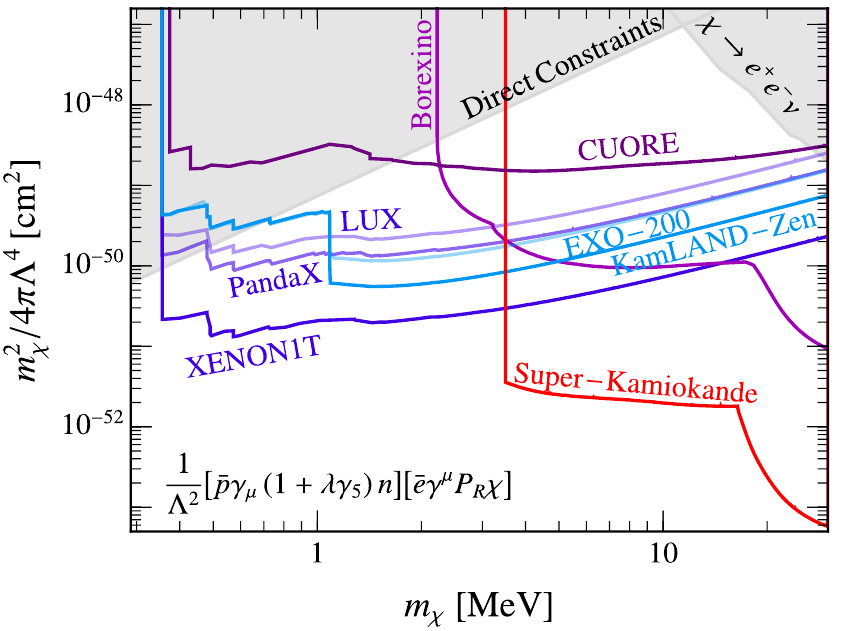
Figure 6 . The projected constraints from a dedicated search for induced (cid:12) (cid:0) signals at XENON1T, LUX, Panda-XII, EXO, and KamLAND-Zen for Xenon conversion. Super-Kamiokande and Borex- ino for absorption by Hydrogen, and by TeO 2 crystals in CUORE. The various experiments, their exposures and physics goals are summarized in appendix